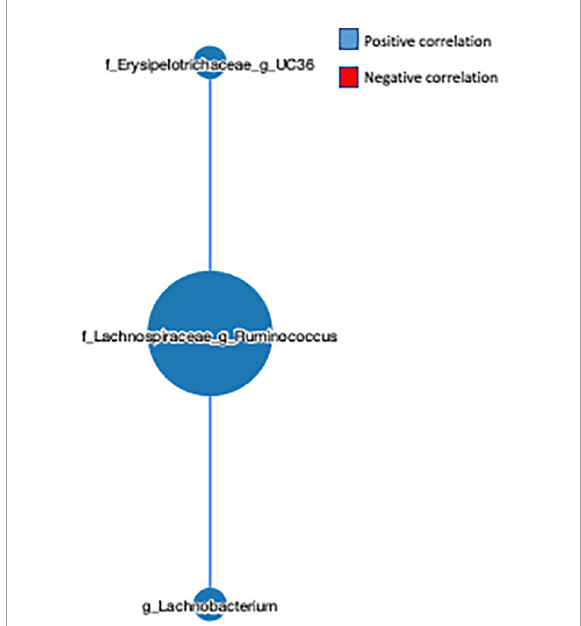
FIGURE5 Microbial network analysis performed using a MetagenoNets webtool. The analysis revealed that L- Ruminococcus positively regulates the unclassified bacteria from the Erysipelotrichaceae family and the genus Lachnobacterium . Blue color indicates a positive correlation, whereas red color indicates a negative